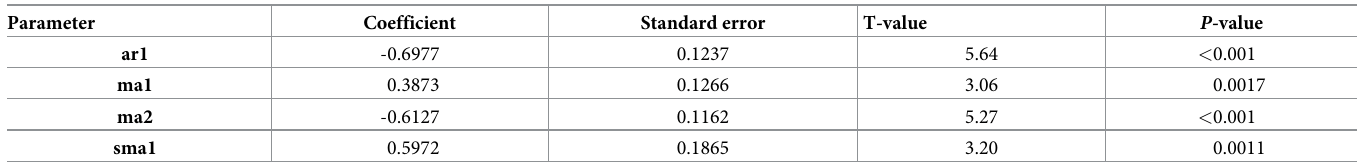
Table 3. Parameters estimation for ARIMA (1,1,2) × (0,0,1) 12 model.